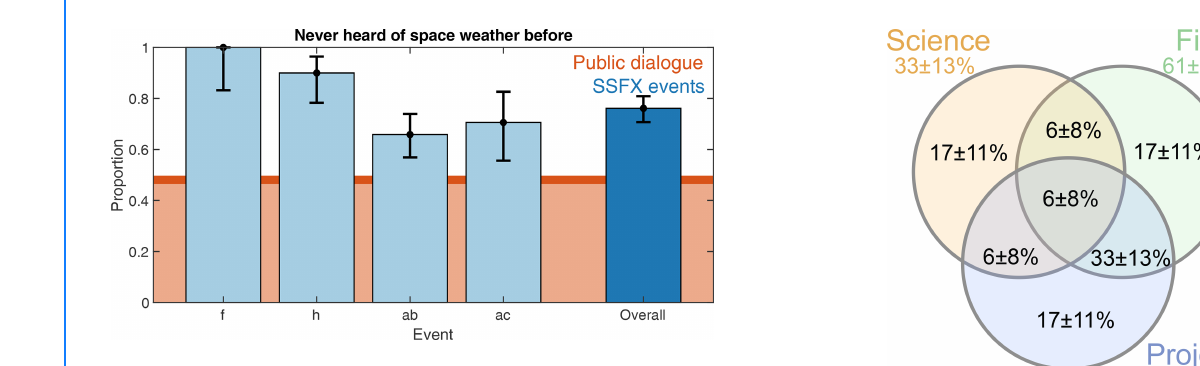
Figure 6. Prior knowledge of audience at SSFX art–science events in blue compared to a recent public dialogue (3KQ and Colling- wood Environmental Planning, 2015) in orange. Figure 7. Venn diagram of people’s motivations for attending SSFX art–science events in the same format as Fig.